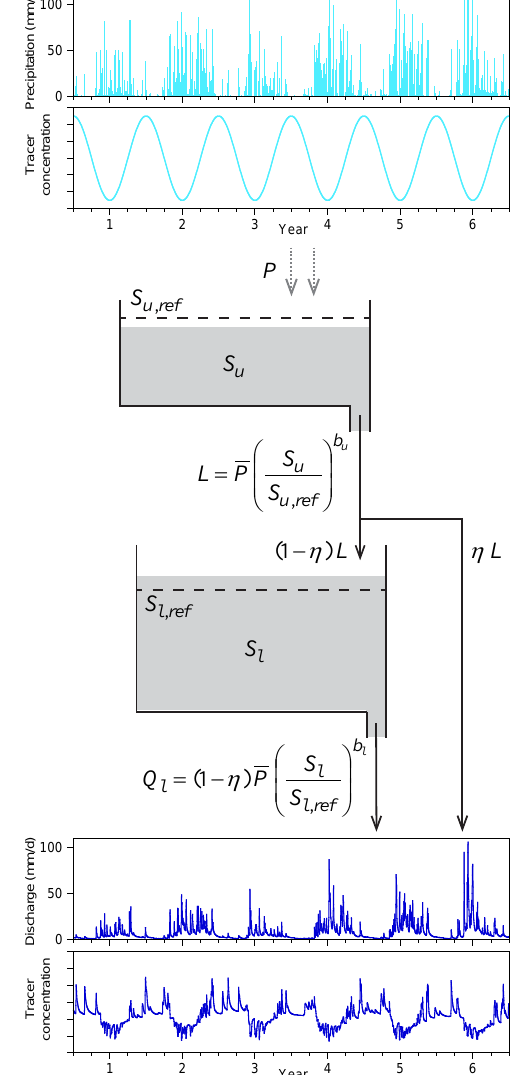
Figure 1. Schematic diagram of conceptual model. Drainage from the upper and lower boxes is determined by power functions of the storage volumes S u and S l (depicted by gray, shaded regions) as ratios of the reference storage levels S u,ref and S l,ref (depicted by dashed lines). The partition coefficient splits the upper box drainage L into direct discharge and infiltration to the lower